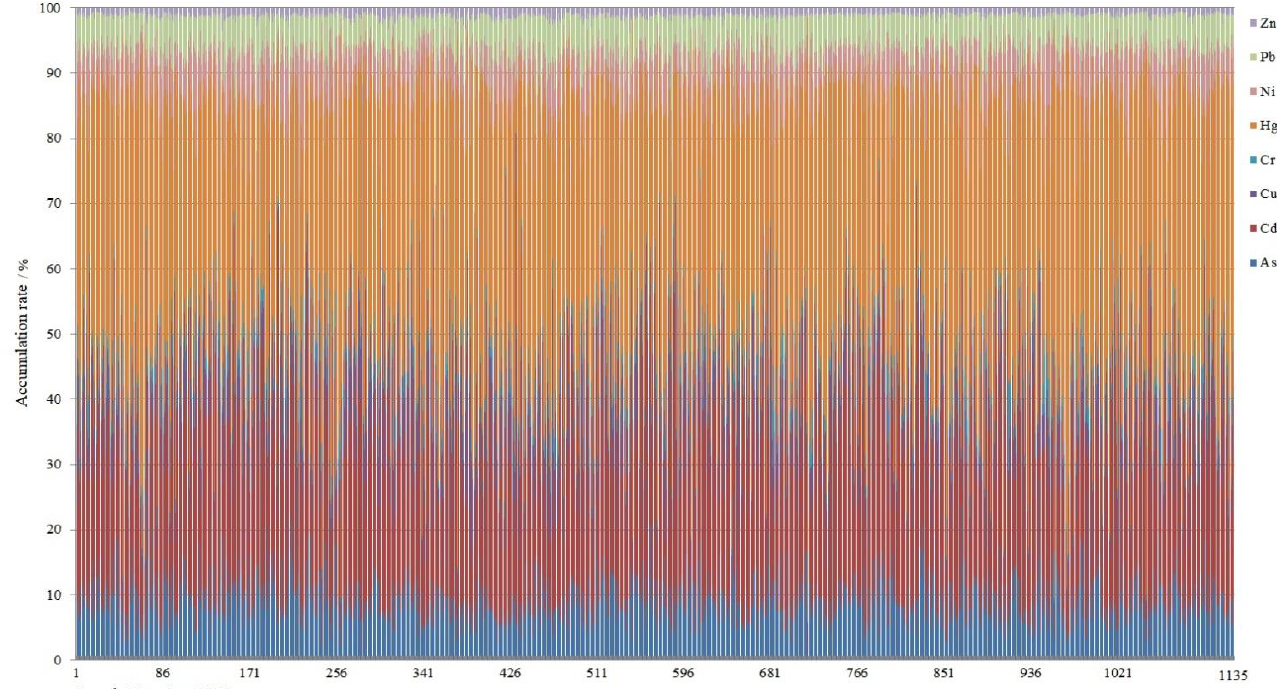
Figure 8. Accumulation rate of the ecological risk ( E r ) of heavy metals.